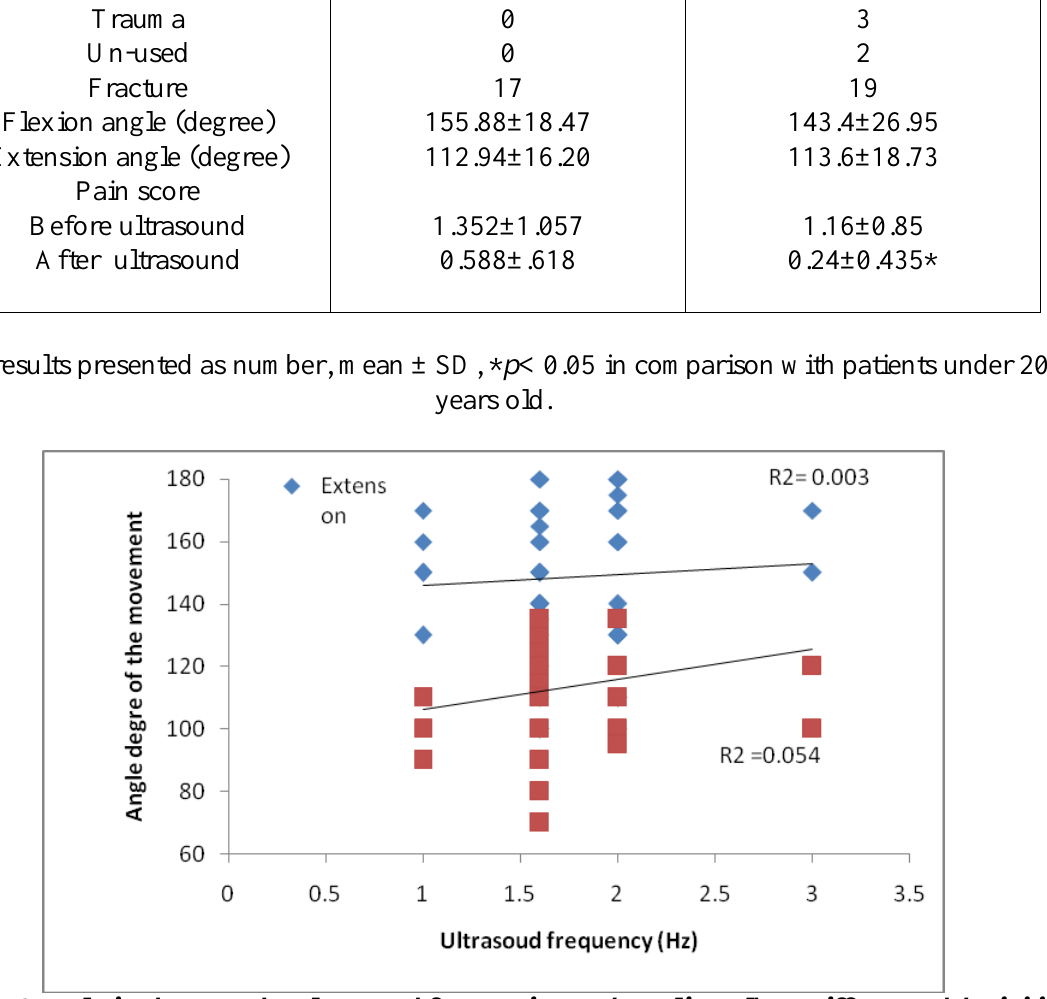
Fig. 2: Correlation between the ultrasound frequencies used to relieve elbow stiffness and the initial angle degree of flexion and